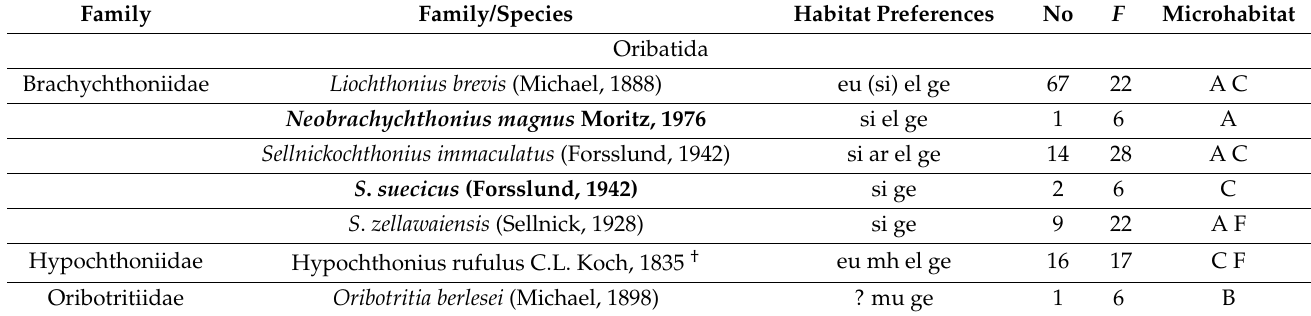
Table 1. Total number of individuals (No) and frequency ( F , in %, proportion of samples) of mites in broadleaf forest in Eastern Norway and occurrence in microhabitats: A—moss on ground, B—lichens on tree twigs lying on ground, C—moss on tree trunks at ground level, D—moss on tree trunks 1.5 m above ground, E—moss on decaying stump, F—moss on decaying log, G—decaying wood from trees; habitat preferences: aquatic (aq), arboricolous (ar), epilithic (el), epiphytic (ep), eurytopic (eu), geophilous (ge), hygrophilous (hy), lichenicolous (li), merocenophilous (mer), mesohygrophilous (mh), muscicolous (mu), praticolous (pr), silvicolous (si), tyrphophilous (ty), xerophilous (xe), xylophilous (xy), unclear (?); in bold—species new to Norway.